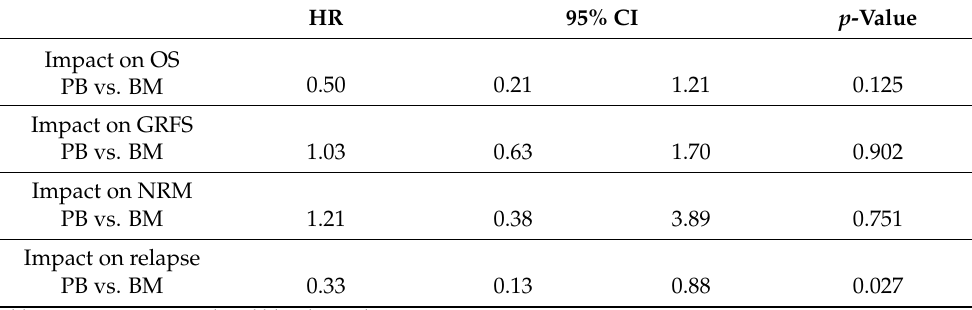
Table 5. Multivariable analysis on risk of relapse, adjusting for confounding variables. HR 95% CI PB vs.